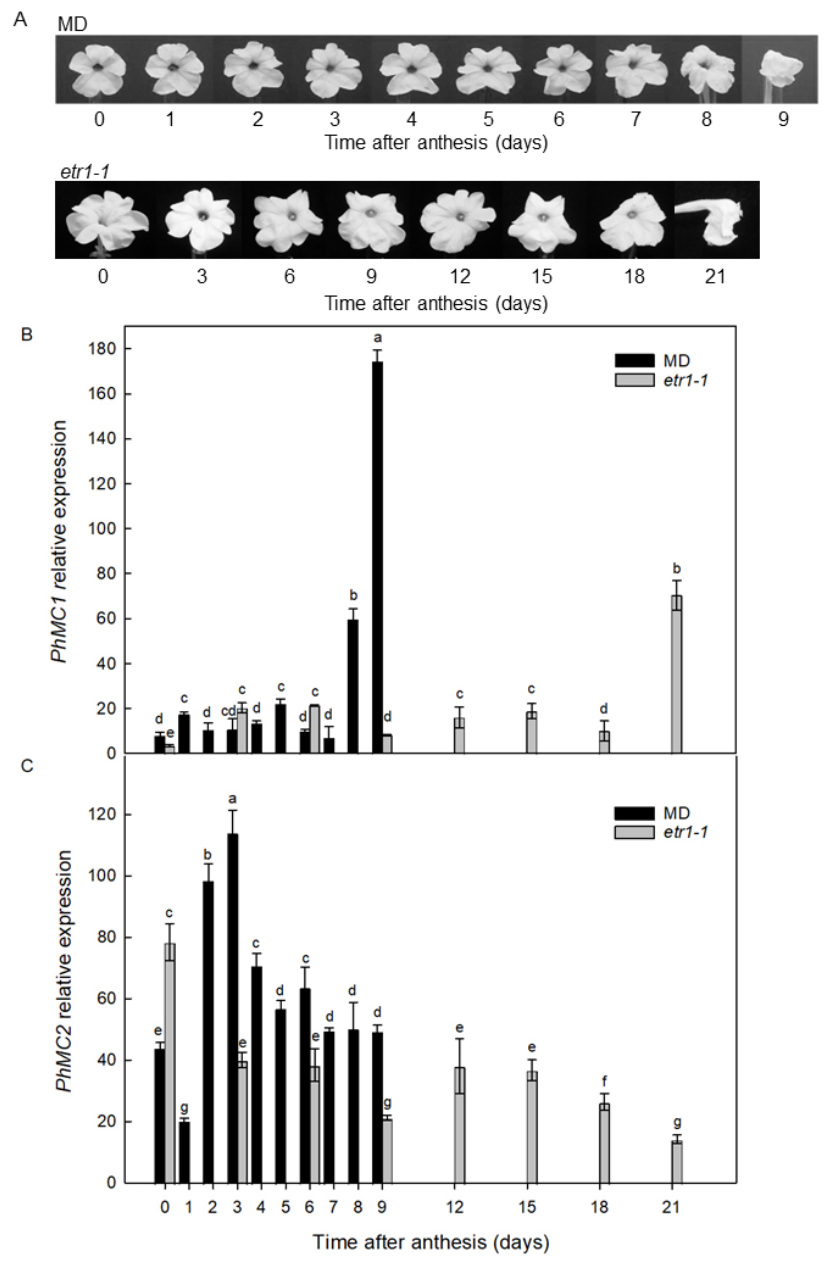
Figure 3. Metacaspase gene expression during corolla development. ( A ) Petunia × hybrida ‘Mitchell Diploid’ (MD) and ethylene insensitive transgenic petunia (35S:: etr1-1 line 44568) flower development from anthesis (0 days) through senescence and corolla wilting. Numbers indicate the days after anthesis or flower opening. Transcript levels (mean ± SD, n = 3) of ( B ) PhMC1 and ( C ) PhMC2 in MD and etr1-1 corollas during flower development. Relative mRNA abundance compared to PhACTIN was determined by quantitative PCR. All data are the means of three replicates ± SE ( n = 3). Different letters represent statistically significant difference between the means ( p ≤